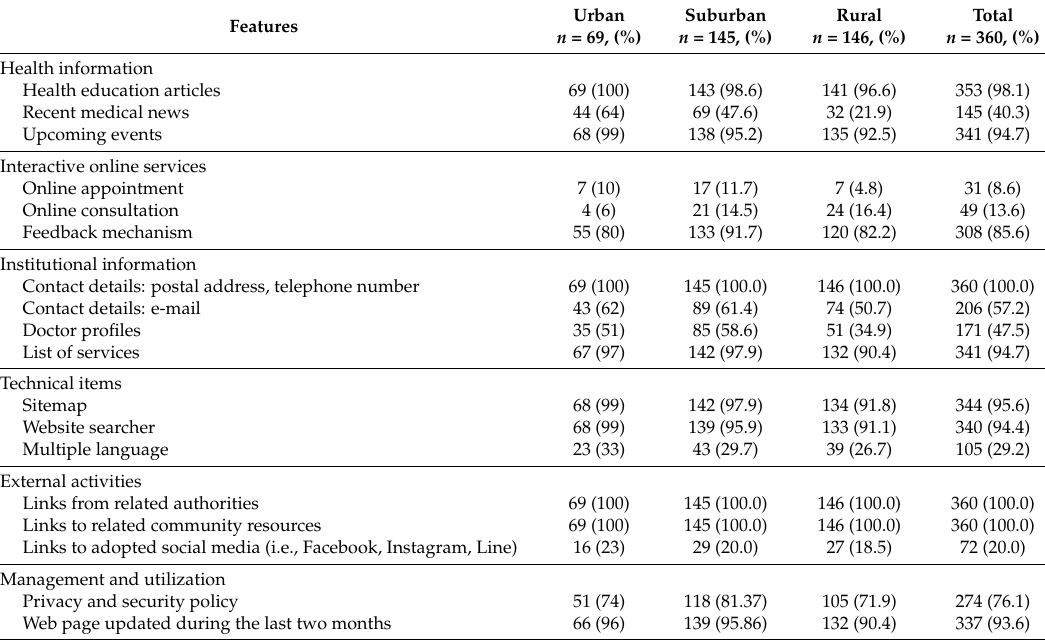
Table 2. Features of official websites of all LHCs ( n = 360).